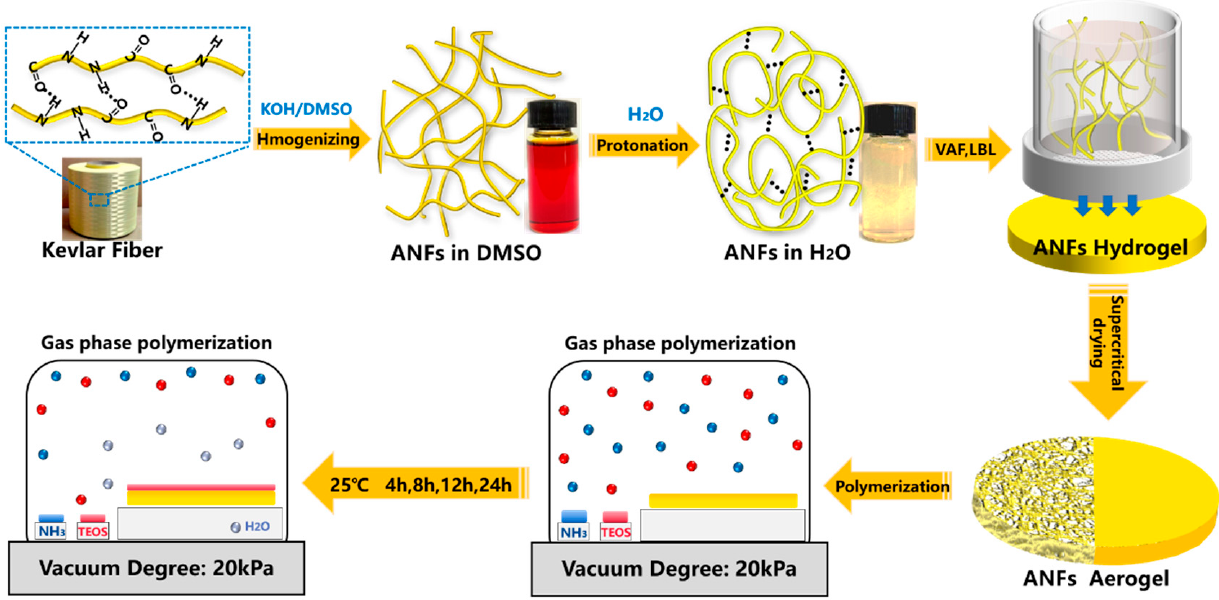
Figure 1. Schematic diagram of fabrication process of aramid fibers@silica aerogel. The FTIR spectra of the ANFs and the ANFs/TEOS-8 (in Figure 3, the aramid fibers@silica aerogel (CVD 8 h) were well-performed. Compared with Kevlar fiber, the transmittance and sharpness of the IR peaks of ANFs were decreased due to the broader distribution of bond lengths and surface states of the fibers [26]. For the ANFs, the characteristic peaks that were located at 3326.1 cm − 1 and 722.4 cm − 1 were ascribed to the stretching vibration and out-of-plane bending vibration of the N-H bond of the aramid nanofibers amide group. The characteristic peaks of the C=O stretching vibration of aramid nanofibers amide groups appeared at 1652.4 cm − 1 in Figure 3. The peaks that were located at 1514.7 cm − 1 and 1316.0 cm − 1 were ascribed to the stretching vibration of C=C groups of the benzene ring and stretching vibration of Ph-N. For the ANFs/TEOS-8 aerogels, broad peaks located at 1068.6 cm − 1 were observed, which were due to the formation of a large number of Si-O-Si and Si-O groups of aramid fibers@silica aerogels [45,50]. As shown in the FTIR spectra of the ANFs/TEOS-8, a wide weak peak with a certain degree of redshift appeared at the position where the characteristic peak of stretching vibration of N-H ought to occur, which indicates that the intermolecular hydrogen bond was formed between the Si-O group of silica and the N-H on the surface of the aramid nanofibers amide